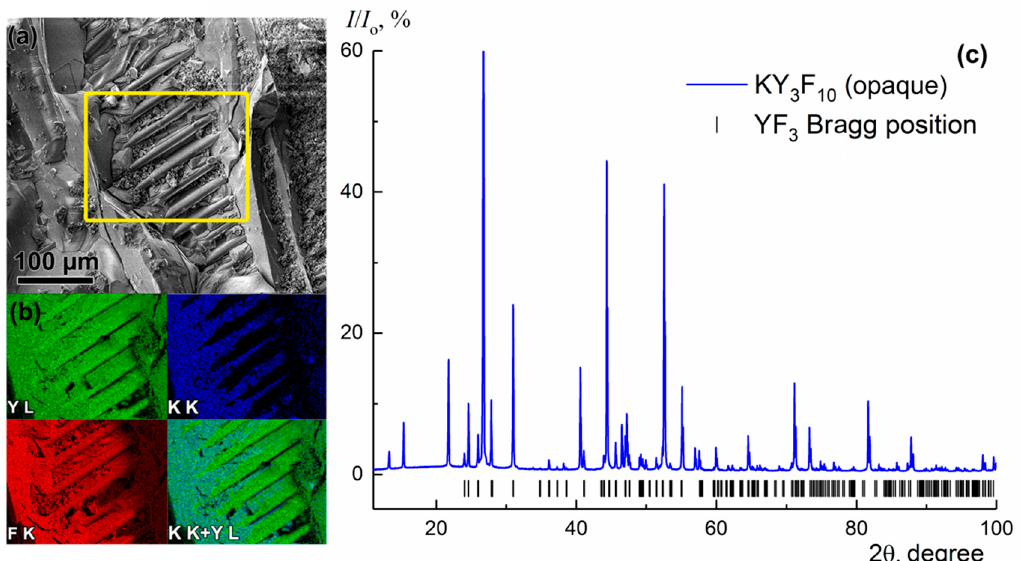
Figure 5. SEM image of opaque KYF crystal part ( a ) and corresponding EDX elemental mapping ( b ) of area marked in ( a ): Y(L)—green, K(K)—blue, F(K)—red and overlapped color map (K + Y); XRD patterns of KYF opaque crystal part, illustrating the presence of two phases simultaneously—KY 3 F 10 and YF 3 ( c ). The positions of Bragg reflection peaks for YF 3 phase (space group Pnma with lattice parameters a = 6.3667(1), b = 6.8583(1), c = 4.3930(1) Å) are indicated.